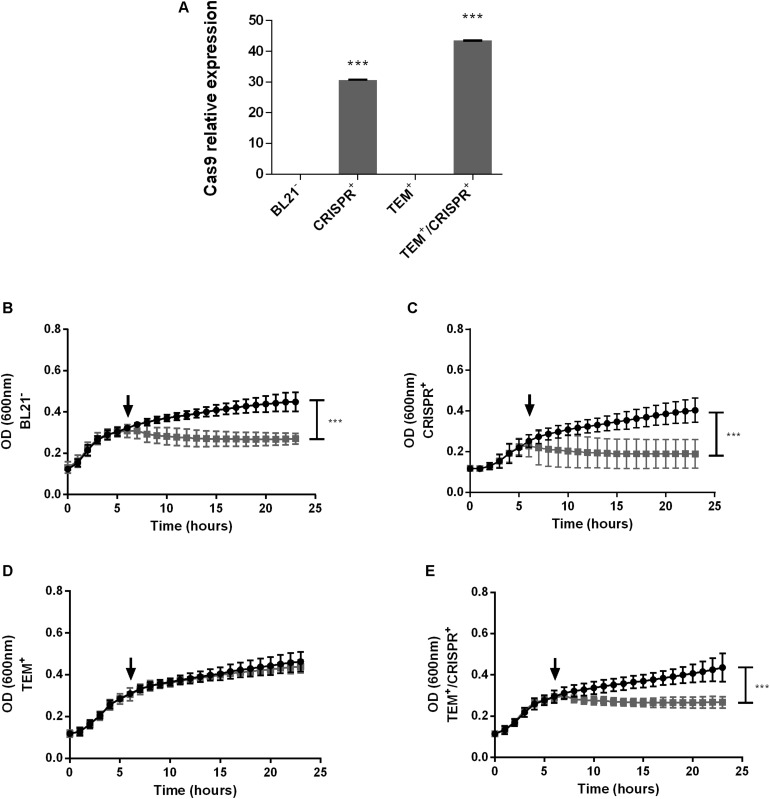
CRISPR-Cas9 expression and growth curves of an E. coli model strain. (A) Relative expression of Cas9 in E. coli BL21; BL21–: BL21 strain with no plasmid, CRISPR+: strain containing the CRISPR-Cas9 system, TEM+: strain containing the blaTEM–1 resistance gene, TEM+/CRISPR+: strain containing blaTEM–1 and CRISPR-Cas9. Normalization was performed based on the 16S rRNA housekeeping gene. Bars represent the mean of two real-time quantitative PCR assays ± standard deviation. (B–E) Growth of E. coli BL21 in the presence (gray curve) or absence (black curve) of ampicillin. (B) BL21–; (C) CRISPR+; (D) TEM+; (E) TEM+/CRISPR+. The time point of ampicillin addition is indicated by a black arrow. Each curve represents the mean of three biological and three technical replicates ± standard deviation. Stars indicate statistical support for differences between strains with or without the CRISPR-Cas9 system, ***p < 0.001.